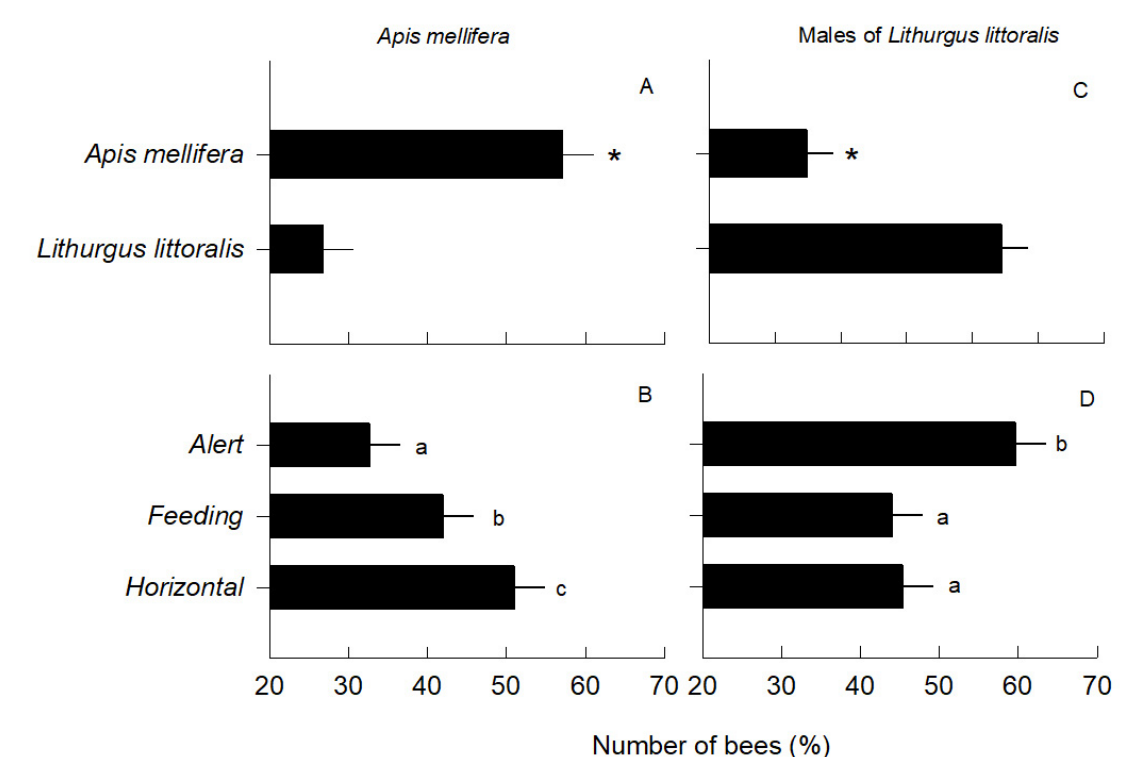
Figure 3. Mean percentage (± SE ) of the number of events with Apis mellifera and Lithurgus littoralis males on the flowers of Opunia huajuapensis with different model species ( A , C ) in three different body positions ( B , D ). Each graph shows the effect of the fixed factors of the two-factor GLM, and asterisks and small letters (a, b, and c) on the bars show the significant differences between mean values.